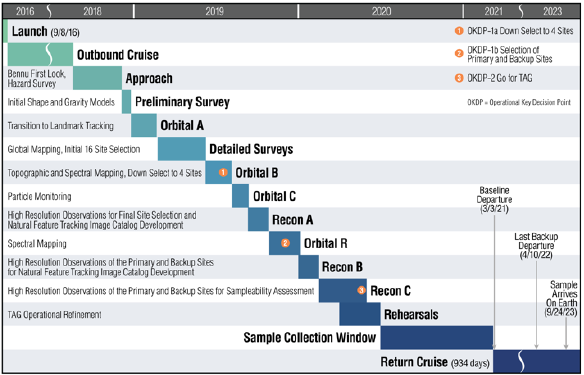
Figure 2. Timeline of OSIRIS-REx mission phases and associated science products (adapted from Lauretta et al.,